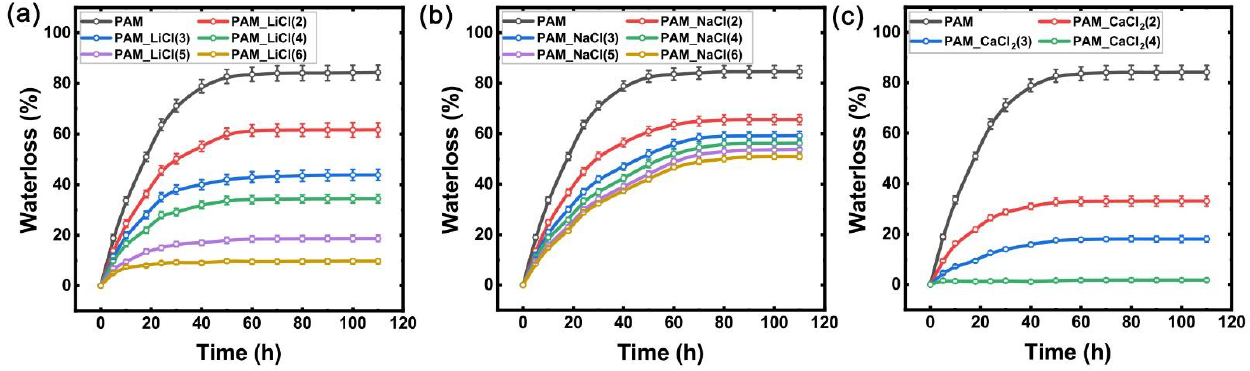
Figure 3. Evolutions of water loss with time for different hydrogel samples kept in environment with temperature of 25 °C and relative humidity (RH) of 60%: ( a ) PAM_LiCl(m); ( b ) PAM_NaCl(m); with temperature of 25 ◦ C and relative humidity (RH) of 60%: ( a ) PAM_LiCl(m); ( b ) PAM_NaCl(m); ( c ) PAM_CaCl 2 (m). ( c ) PAM_CaCl 2